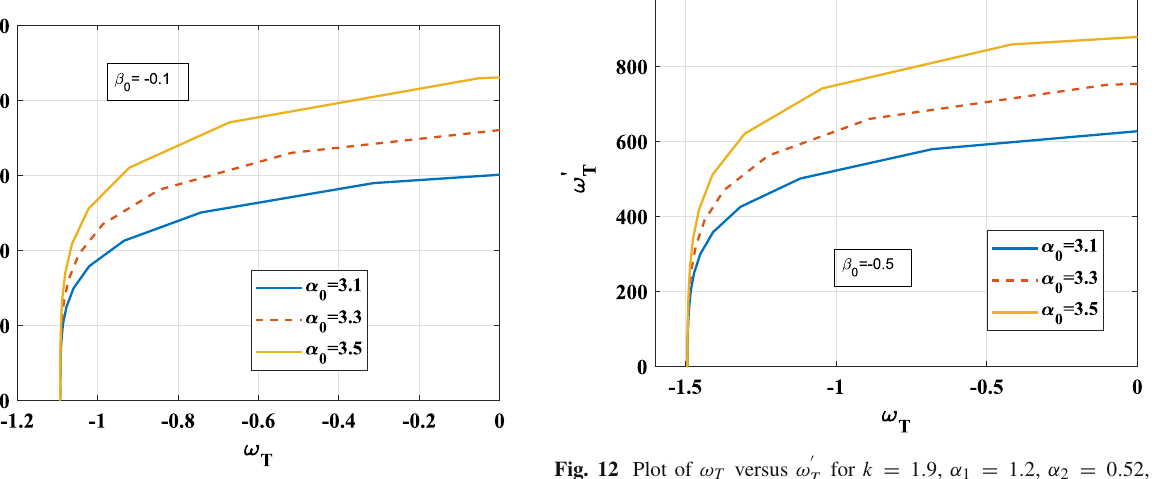
for k = 1 . 9, α 1 = 1 . 2, α 2 = 0 . 52, T